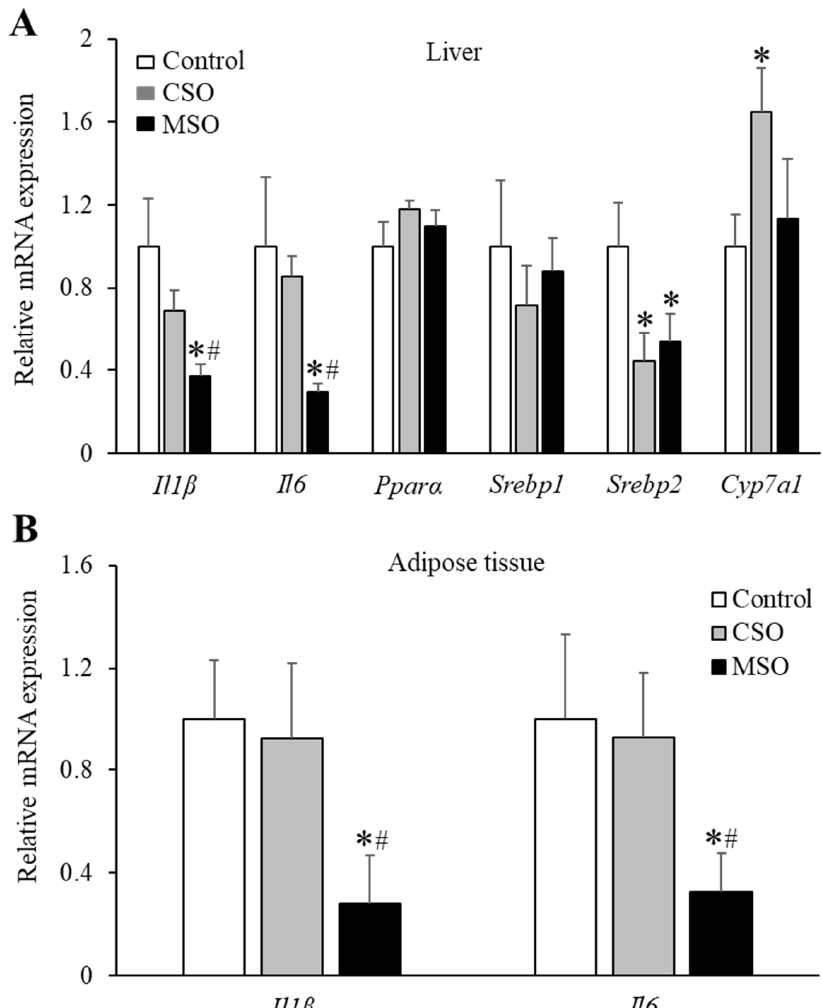
Figure 5. Effects of dietary CSO and MSO on gene expression in LDLR-KO mice. Mice (n = 12/group) were fed a Western diet supplemented with 5% ( w / w ) CSO, MSO, or none (control) for 12 weeks. ( A ) Liver mRNA expression of genes involved in inflammation ( Il1 β and Il6 ) and lipid metabolism ( Ppar α , Srebp1 , Srebp2 , and Cyp7a1 ). ( B ) mRNA expression of genes related to inflammation ( Il1 β and Il6 ) in white adipose tissue. CSO: conventional soybean oil, MSO: modified soybean oil. Values represent the mean ± SEM. * p < 0.05 compared with the control Western diet; # p < 0.05 compared with the CSO diet.